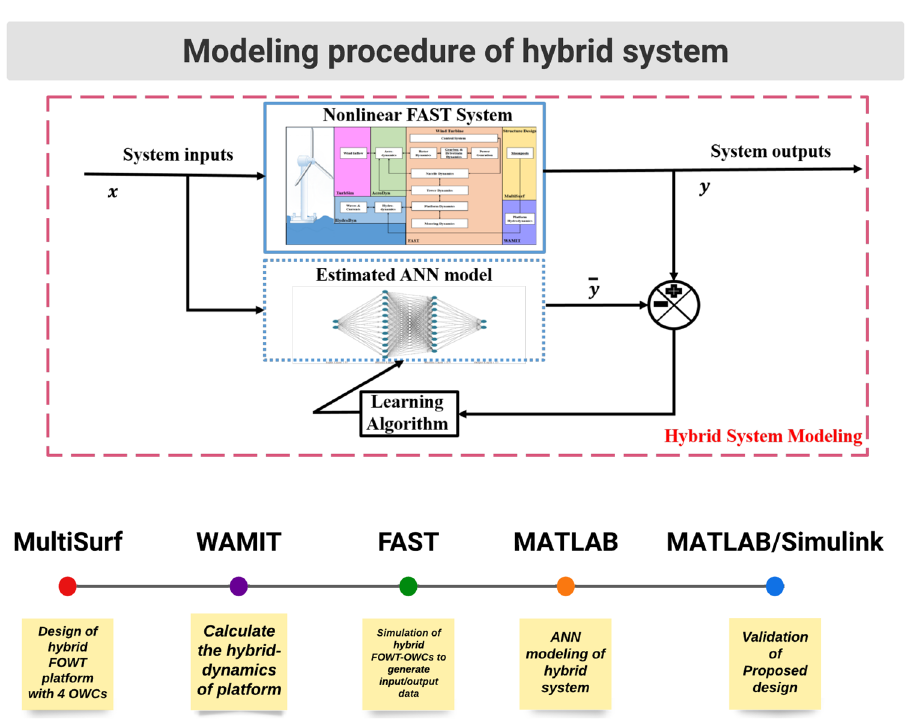
Figure 9. Modeling procedure of the hybrid